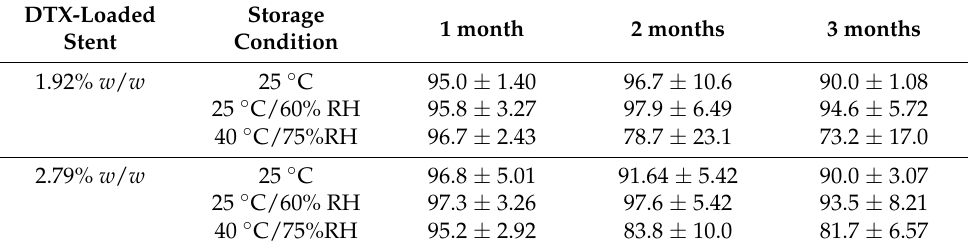
Table 2. Remaining DTX in stent pieces after storage under various conditions over a period of 3 months ( n =